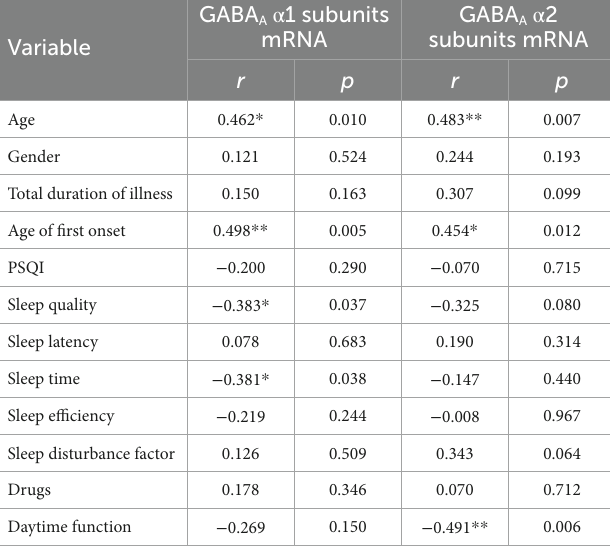
TABLE 2 Analysis of related factors of serum the serum mRNA levels of GABA A receptor α 1 and α 2 subunits in the insomnia disorder group.